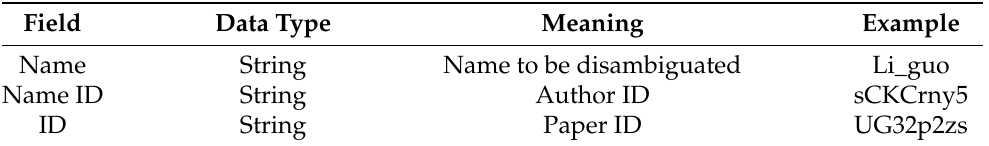
Table 5. Data format of academic literature relationship.